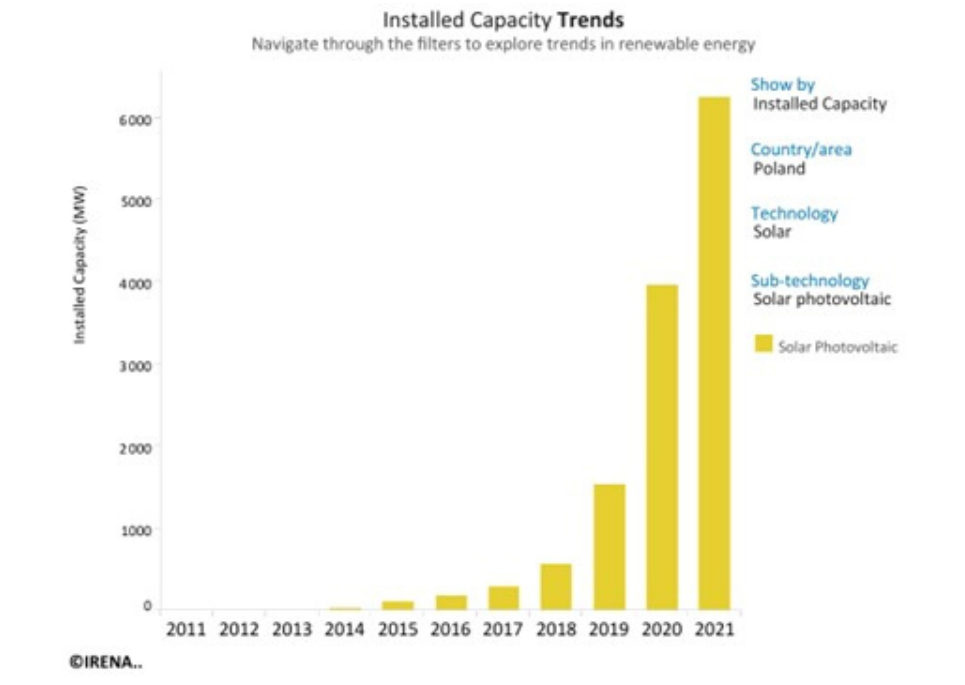
Figure 2. Installed capacity trends in Poland [10].